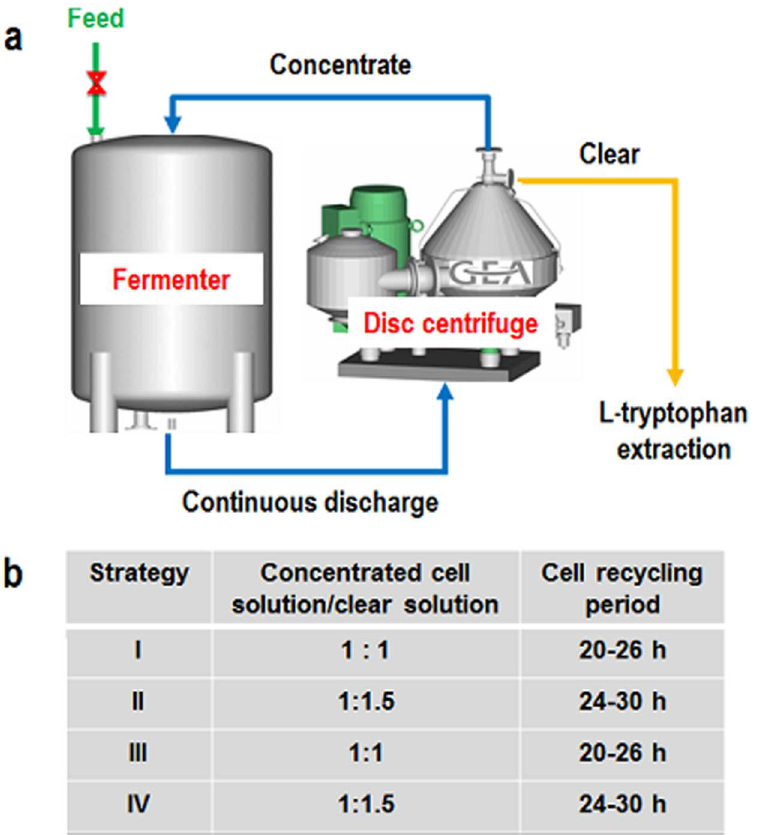
Fig 1. Schematic diagram illustrating the workflow of the cell recycling bioreactor and four cell recycling strategies adopted.